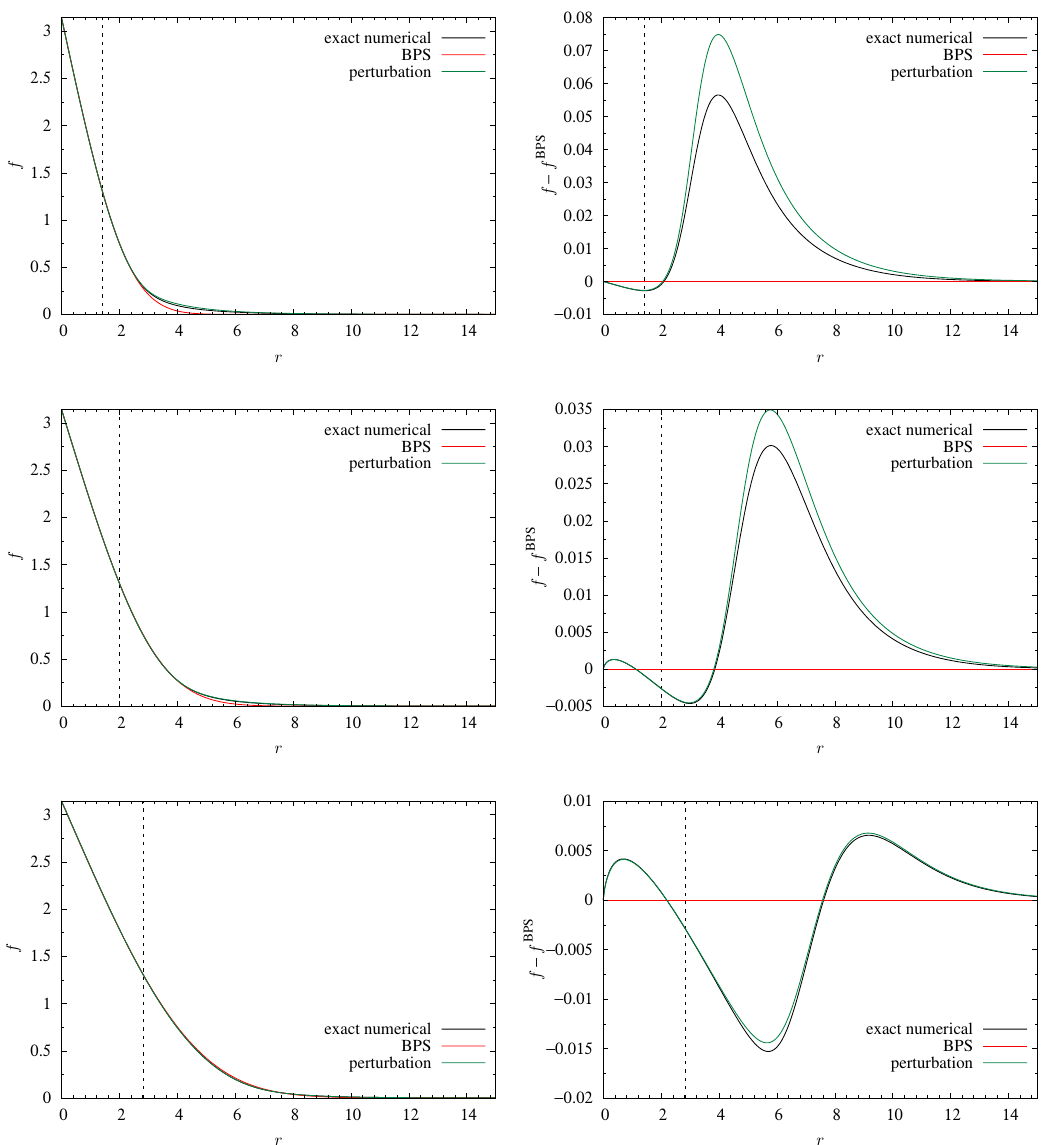
Figure 2. The profile function f = arccos( φ 3 ) for N = 1 , 2 , 4 baby Skyrmions with (cid:15) = 0 . 01 and m 1 = 0 . 5 . The BPS background profile function is shown as a red solid line. The perturbation (dark- green solid line) gets closer to the true solution (black solid line), obtained by numerical calculation, as N gets larger. (a) profile functions. (b) profile function with the BPS one subtracted off. The √ dashed black vertical line marks R = 2 N on each panel, which is the characteristic length scale of the baby